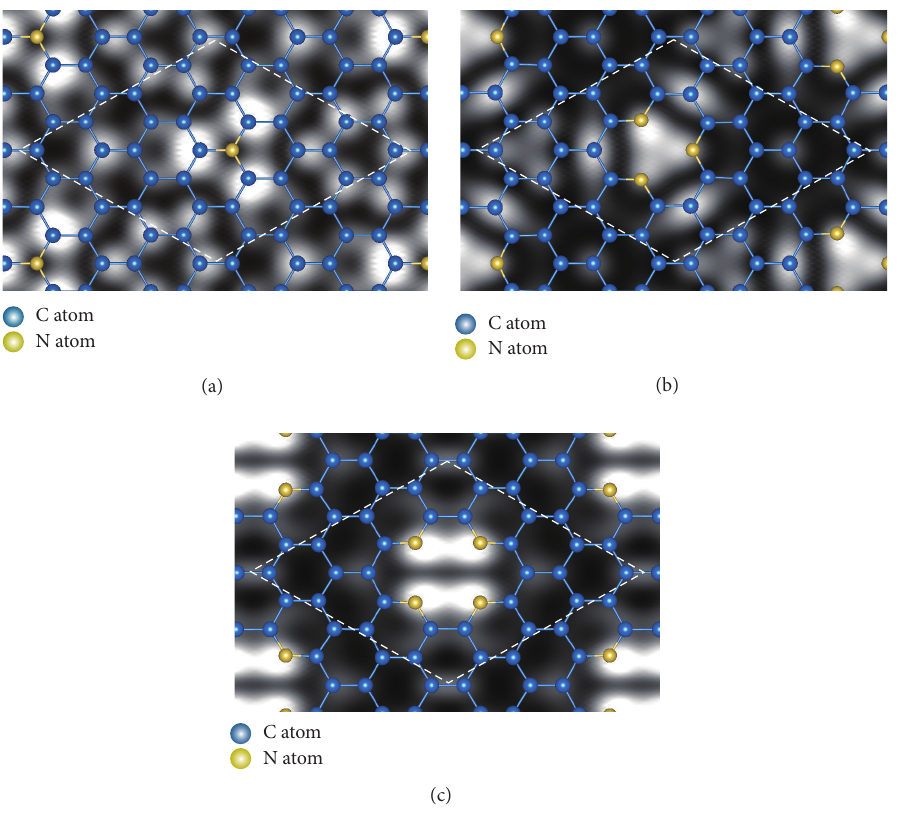
Figure 7: Simulated STM images of (a) substitutional nitrogen, (b) trimerized pyridine-type, and (c) tetramerized pyridine-type defects in graphene. The STM images are calculated at the applied bias voltages of (a) +0.5 eV, (b) − 0.5eV, and (c) − 0.5eV. The dotted line denotes the unit cell. Reproduced with permission from [47], copyright 2011, the American Physical Society.